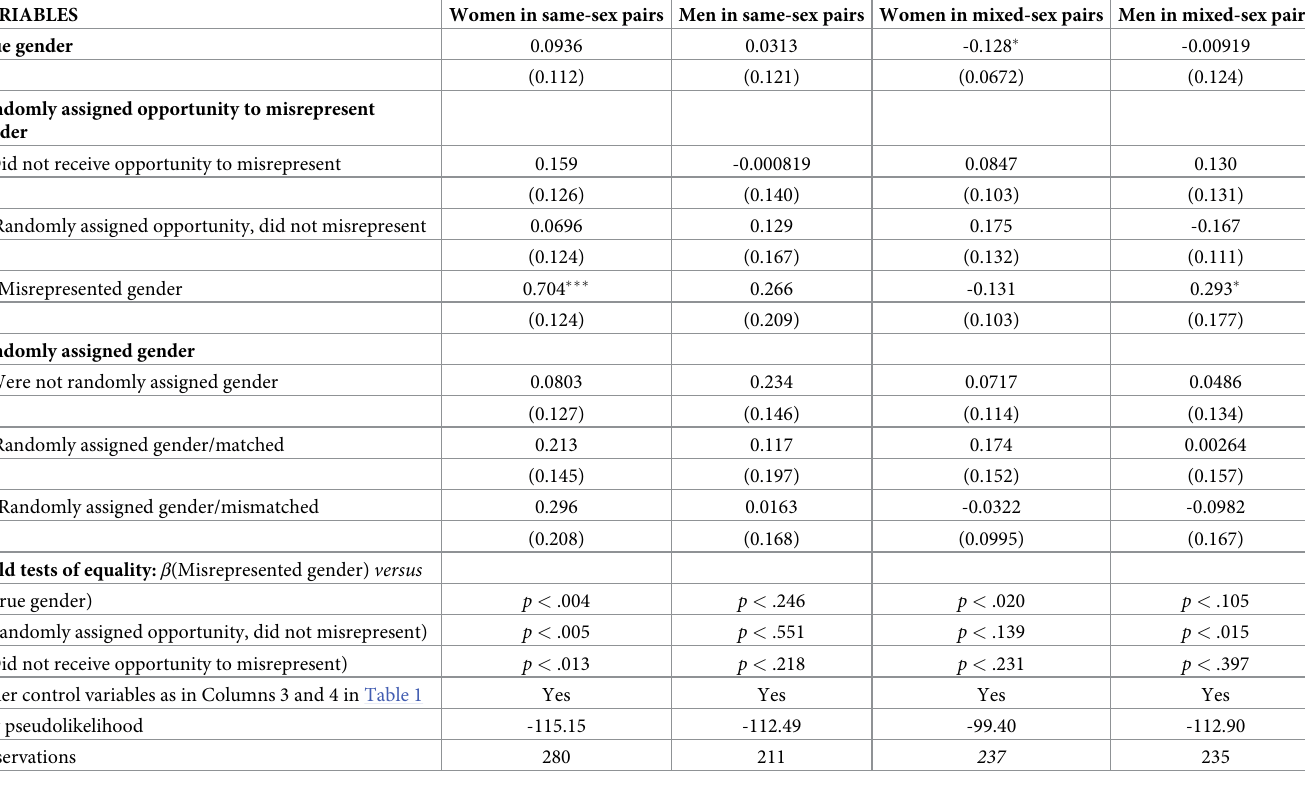
Table 6. Misrepresentation and the propensity to steal by gender pairing.